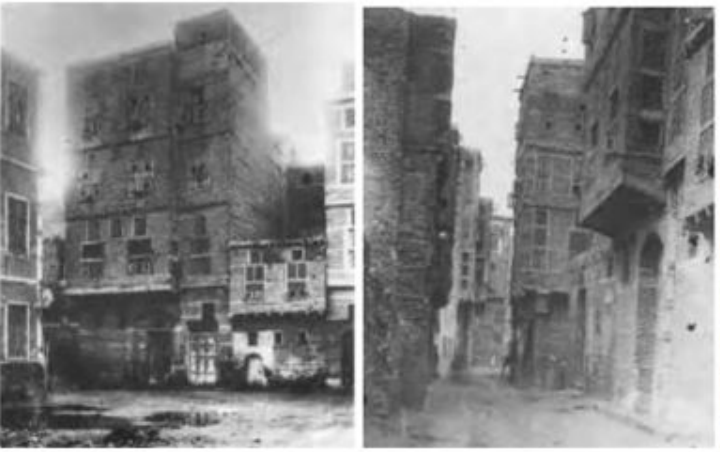
Figure 3. Some ancient postcards of Rosetta houses (”CULTNAT”,